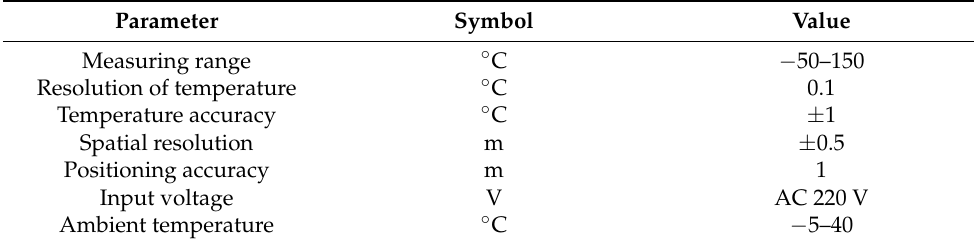
Table 1. Main technical parameters of the DOFTS.